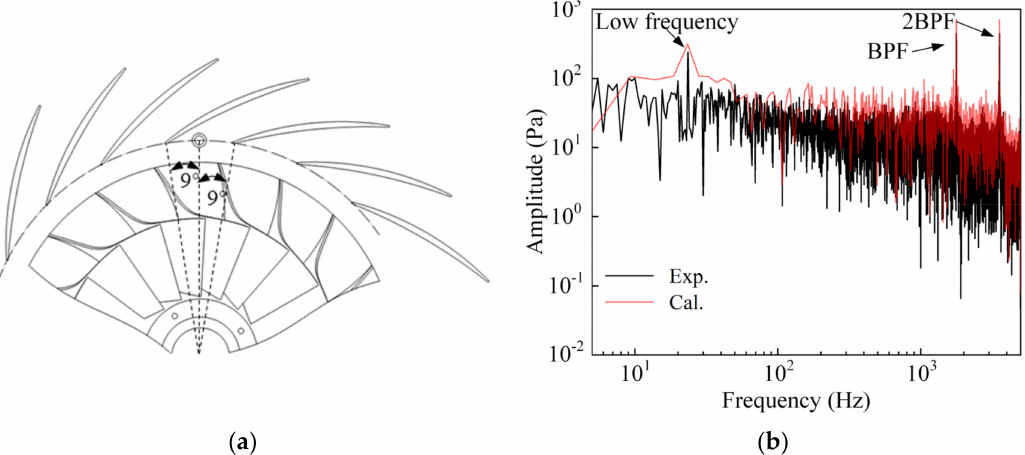
Figure 5. Spectrum analysis of the pressure fluctuations at the inlet of the diffuser: ( a ) the location of monitoring point ( b ) IGV45 ( ϕ =